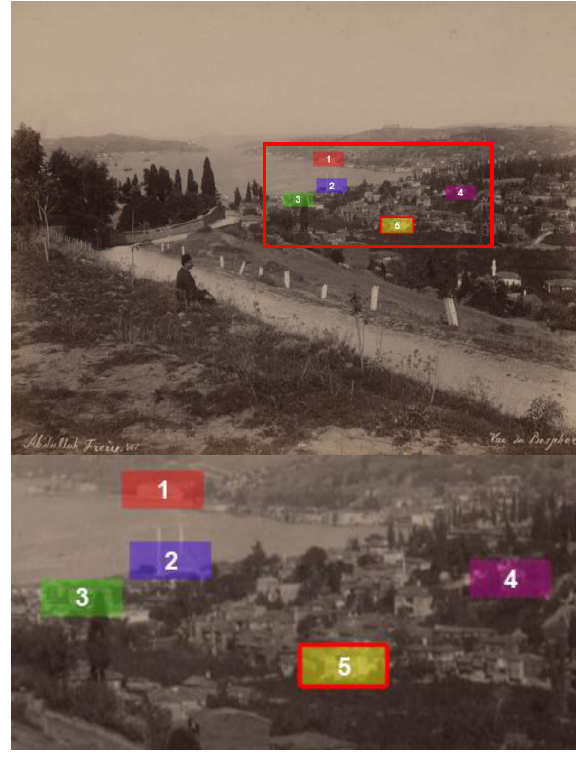
Figure 5. The historical photograph and control points